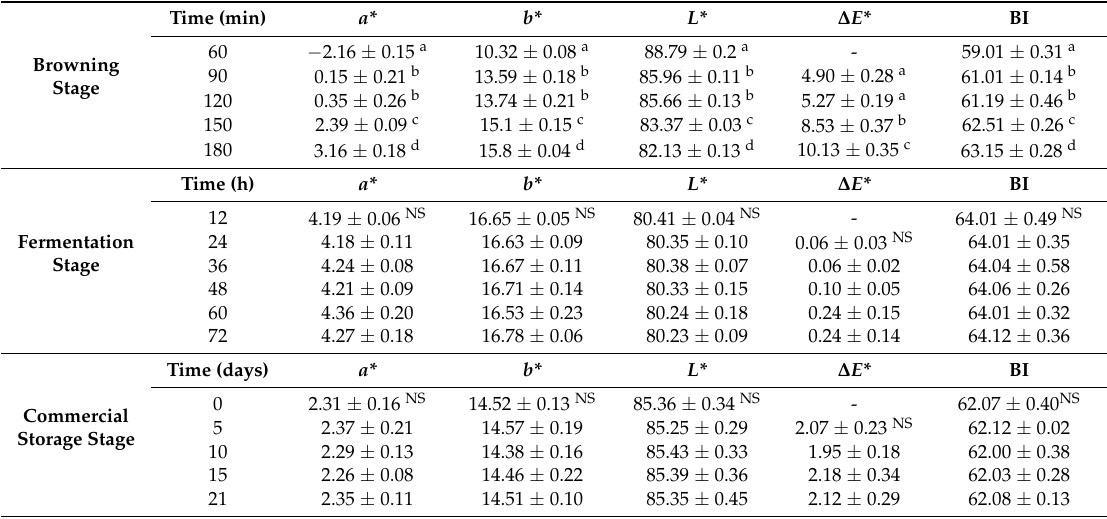
Table 3. Changes in the colour parameters ( a* , b* , L* , ∆ E and BI) during the manufacturing and storage of brown fermented milk